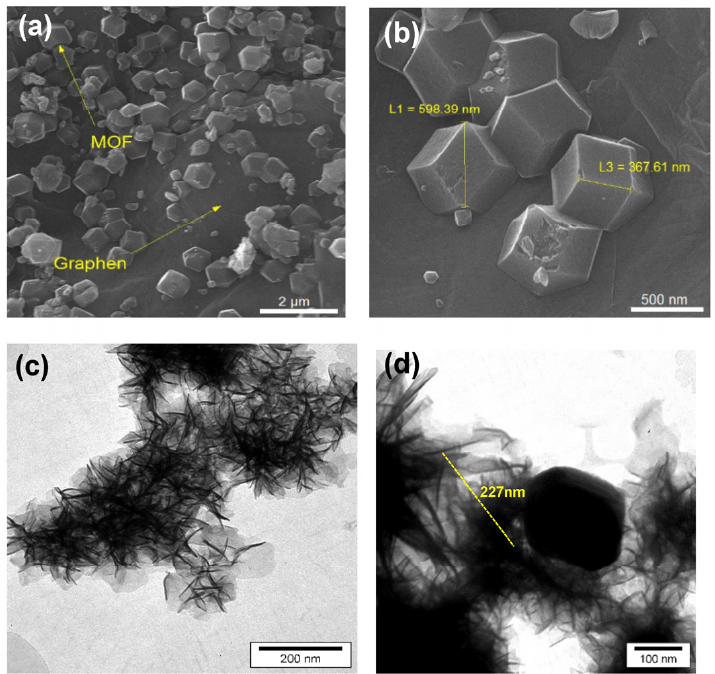
Figure 4. ( a , b ) FESEM image of the ZIF-67/GO nanoparticles at different magnifications. ( c ) TEM image of GO. ( d ) TEM image of the ZIF-67/GO nanocomposites.